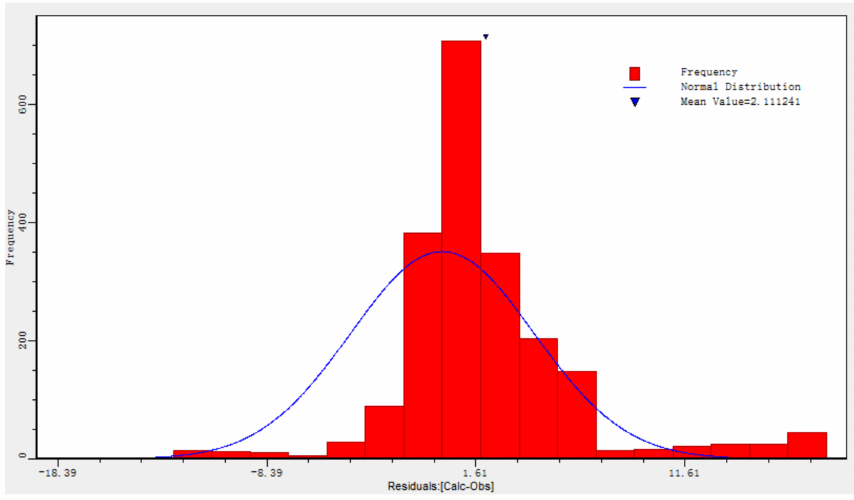
Figure 11. Distribution of water-level fitting error during the verification